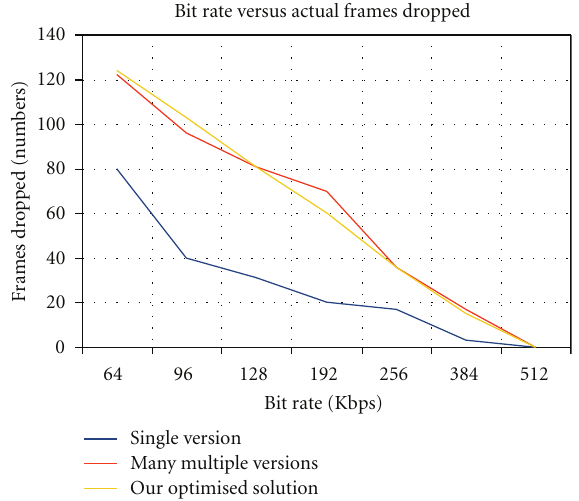
Figure 3: Bit rate (kbps) versus actual no. of packets dropped.